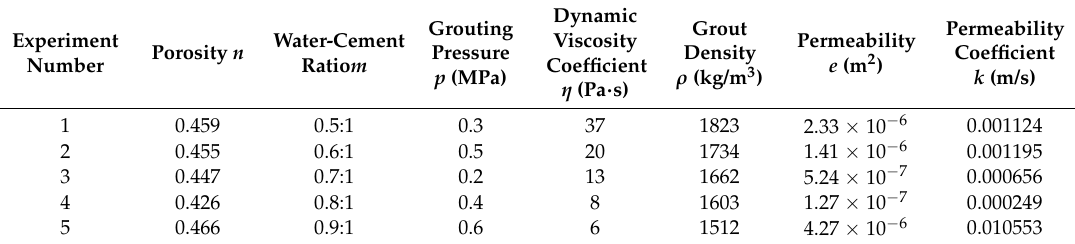
Table 1. The parameters of different experiments.